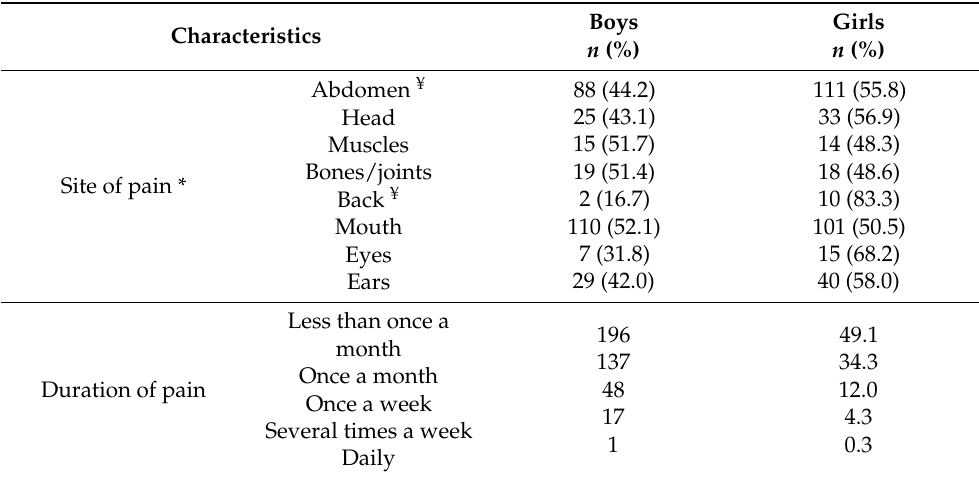
Table 2. Characteristics of children and their pain.